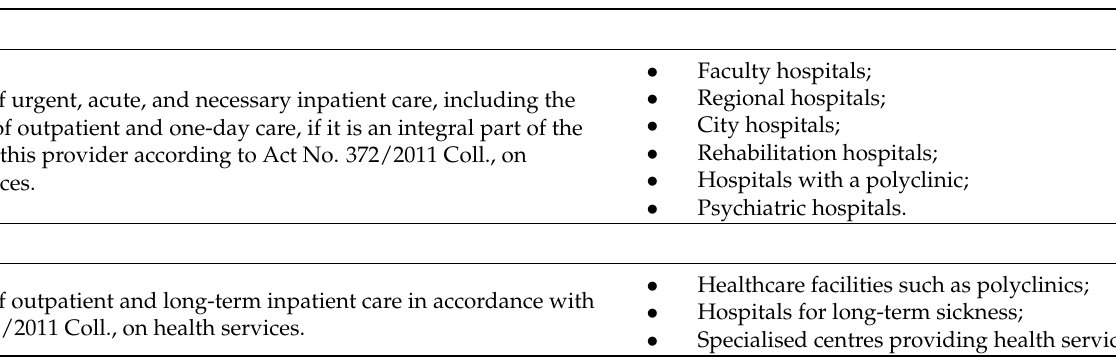
Table 3. Distribution of object priorities in medical facilities [19].